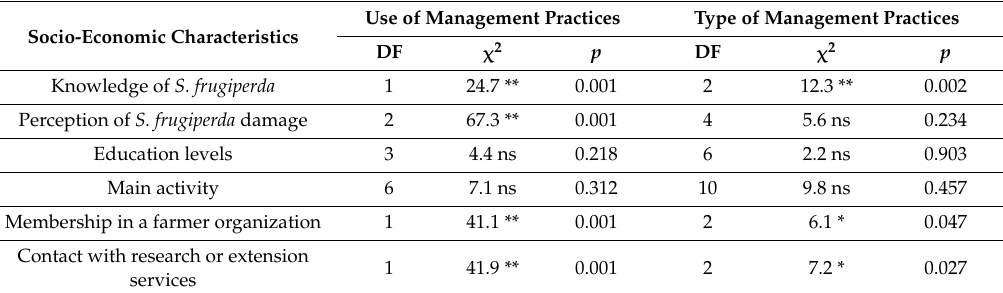
Table 9. Chi-square test analysis of the relationships between farmers’ management practices, knowledge, perceptions, and socio-economic